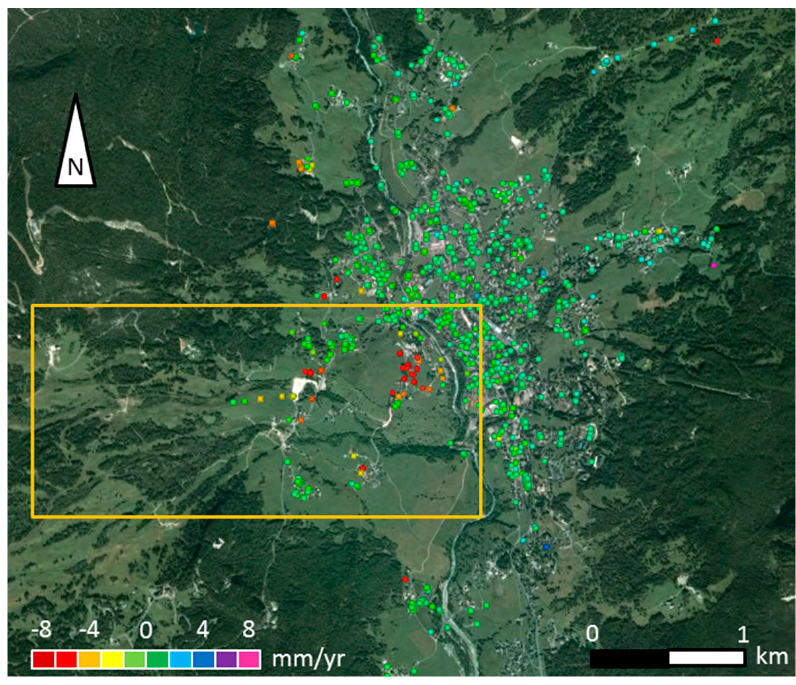
Figure 7. Results of the interferometric point target analysis (IPTA) processing on the ENVISAT dataset (2004–2010). In the orange rectangle is the study area.